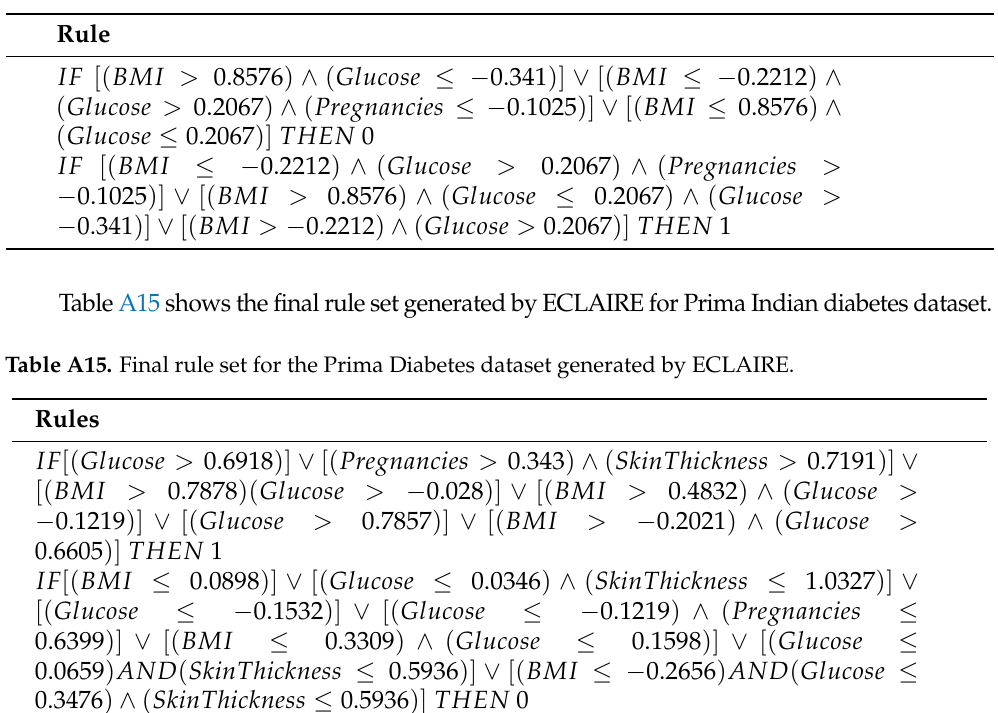
Table A14. Final rule set, for the Prima Indians diabetes dataset, generated by DEXiRE.